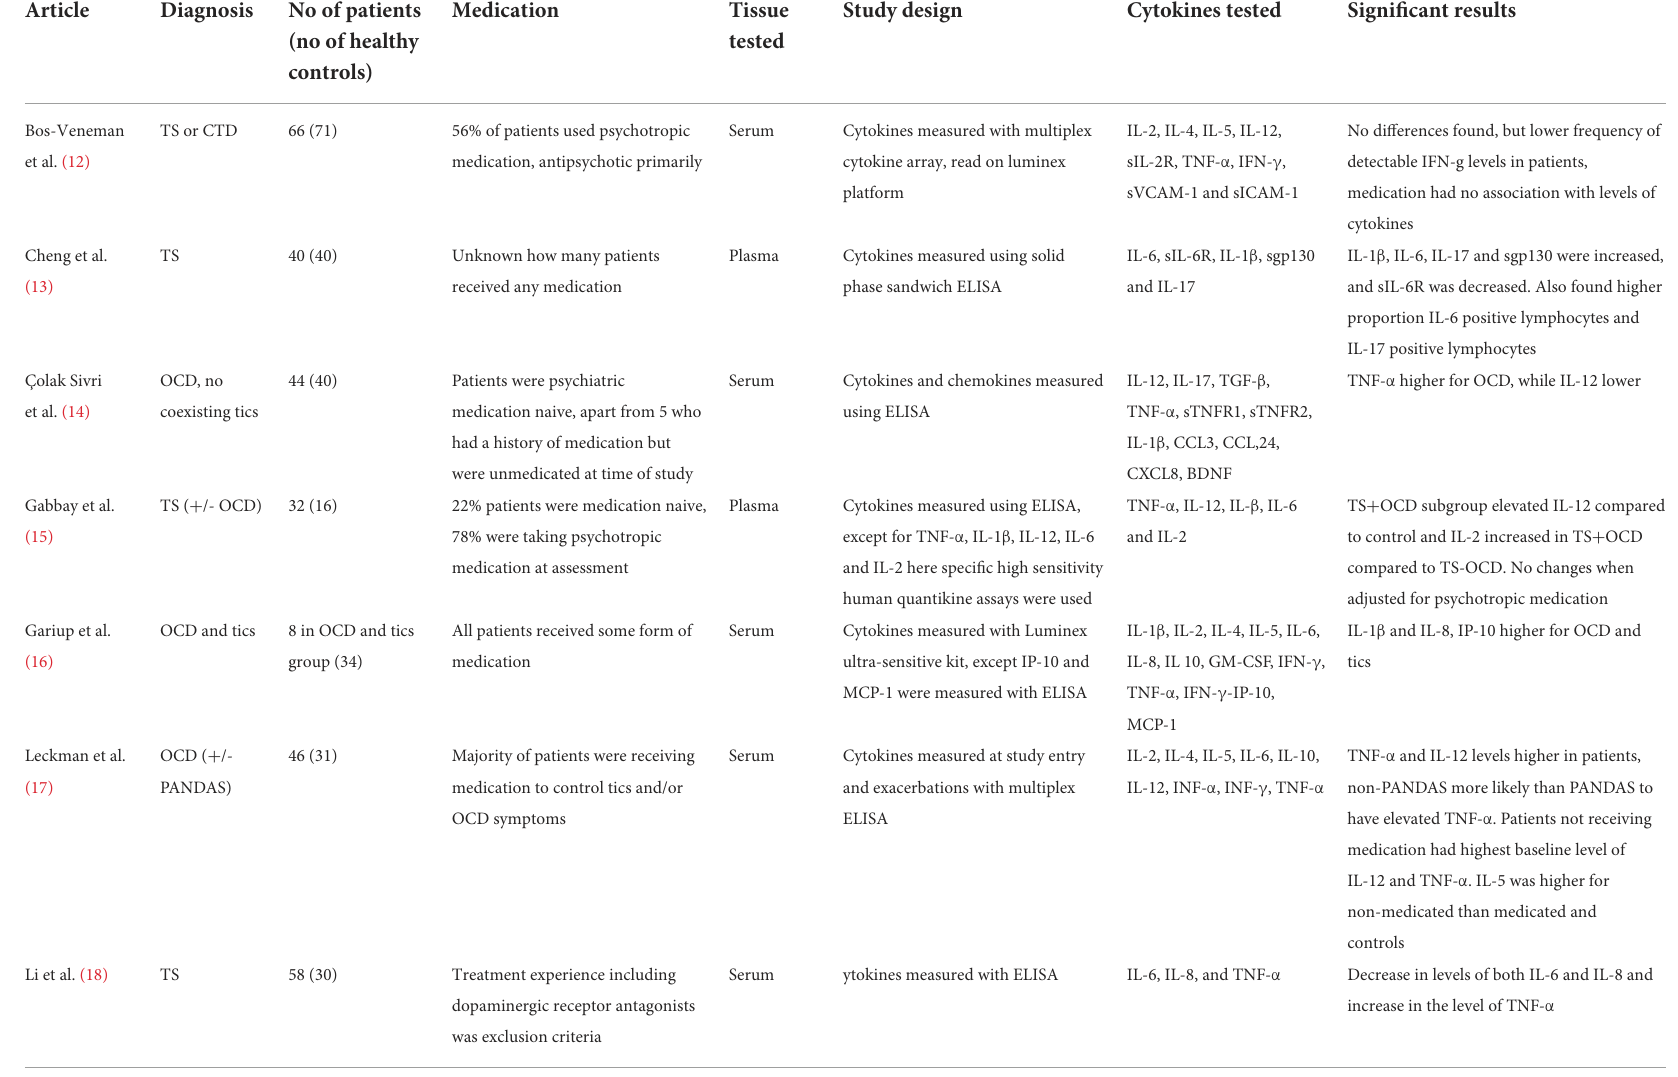
TABLE 1 Studies examining cytokines in pediatric patients with obsessive-compulsive and/or tic symptoms compared to healthy controls.